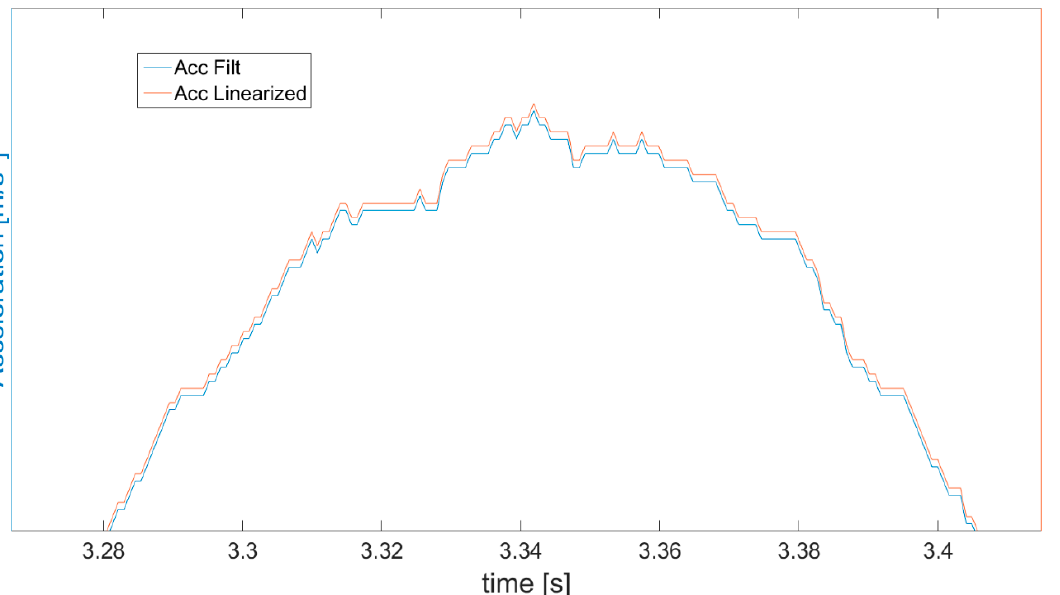
Figure 11. Velocity calculated after acceleration symmetrization (red line—velocity linearized) compared with previous corrected velocity (black line). Finally, the accelerometer estimated displacement S ACC calculated on the basis of final velocity data V ACC , obtained from symmetrized acceleration, is achieved according to Equation (7) and presented in Figure 12 as a magenta line. In order to evaluate the result,